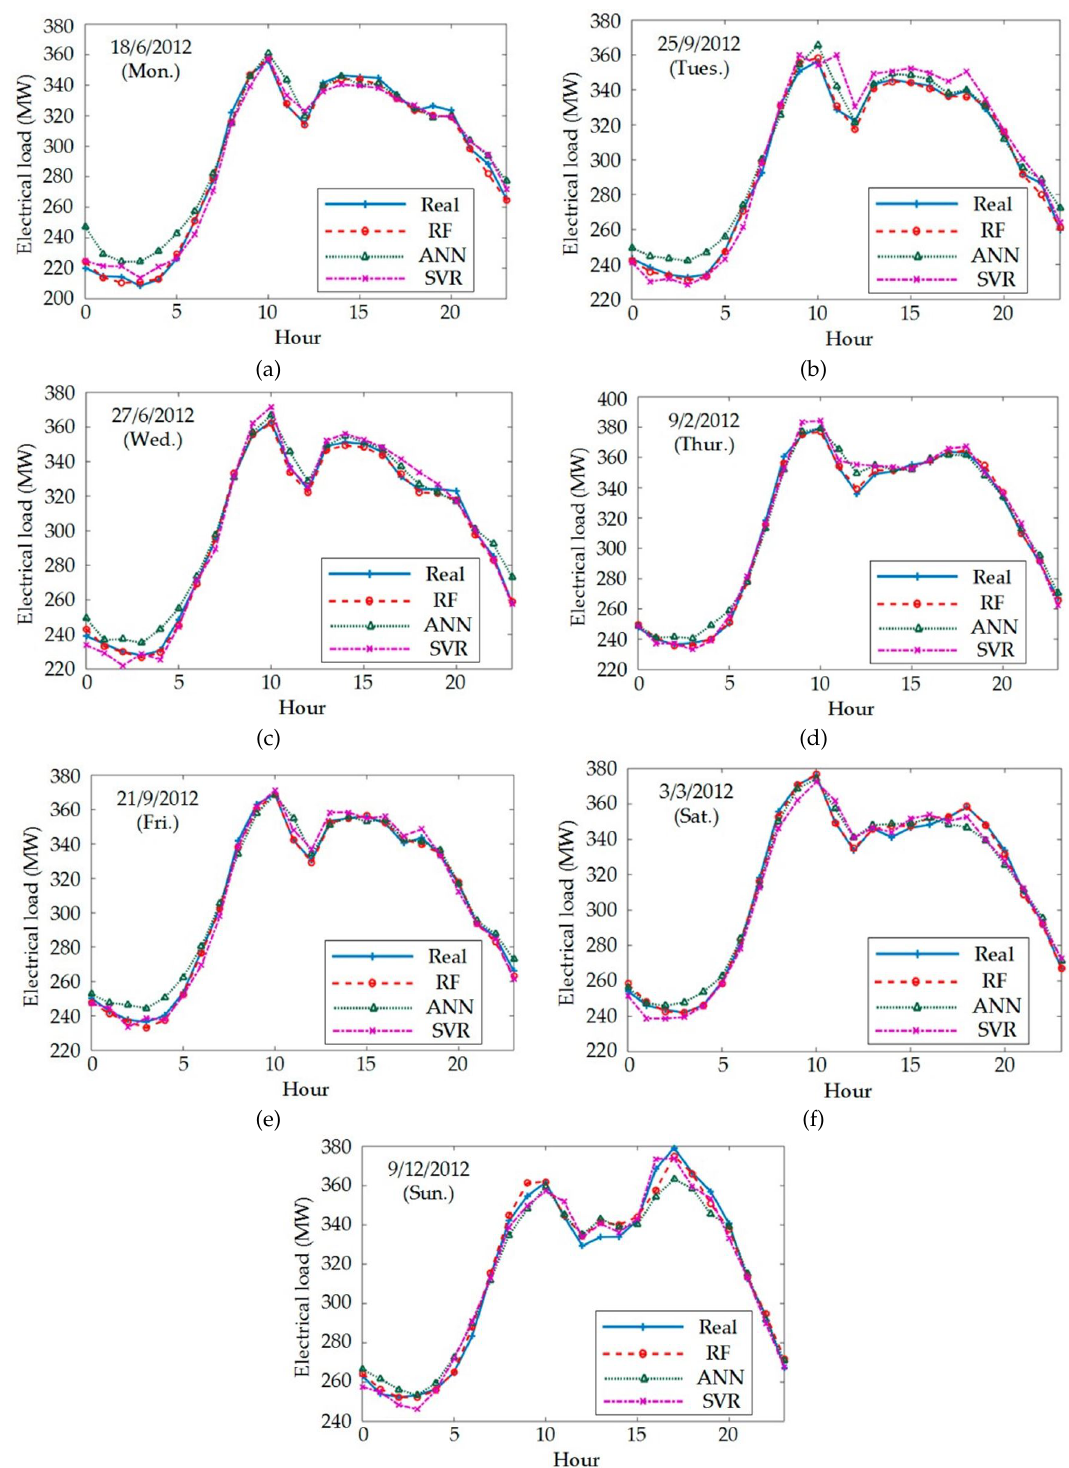
Fig. 4. (a) The comparison of prediction results obtained from 1-h-ahead prediction of June 18th; (b) the comparison of prediction results obtained from 1-h-ahead prediction of September 25th; (c) the comparison of prediction results obtained from 1-h-ahead prediction of June 27th; (d) the comparison of prediction results obtained from 1-h-ahead prediction of February 9th; (e) the comparison of prediction results obtained from 1-h-ahead prediction of September 21st; (f) the comparison of prediction results obtained from 1-h-ahead prediction of March 3rd; (g) the comparison of prediction results obtained from 1-h-ahead prediction of December